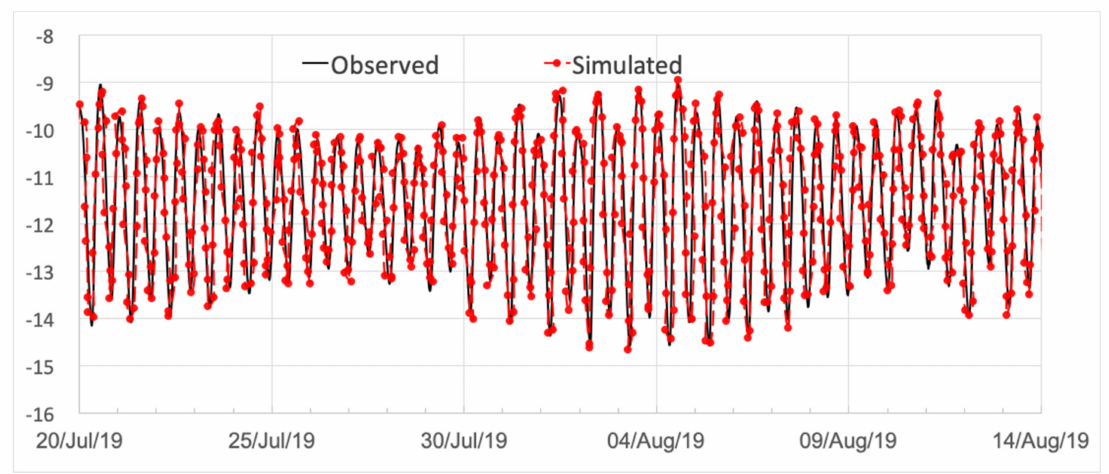
Figure 7. Simulated tidal propagation (dashed red line with dots) and observed tide level data (black line) of Dafeng automatic telemetry station (unit: